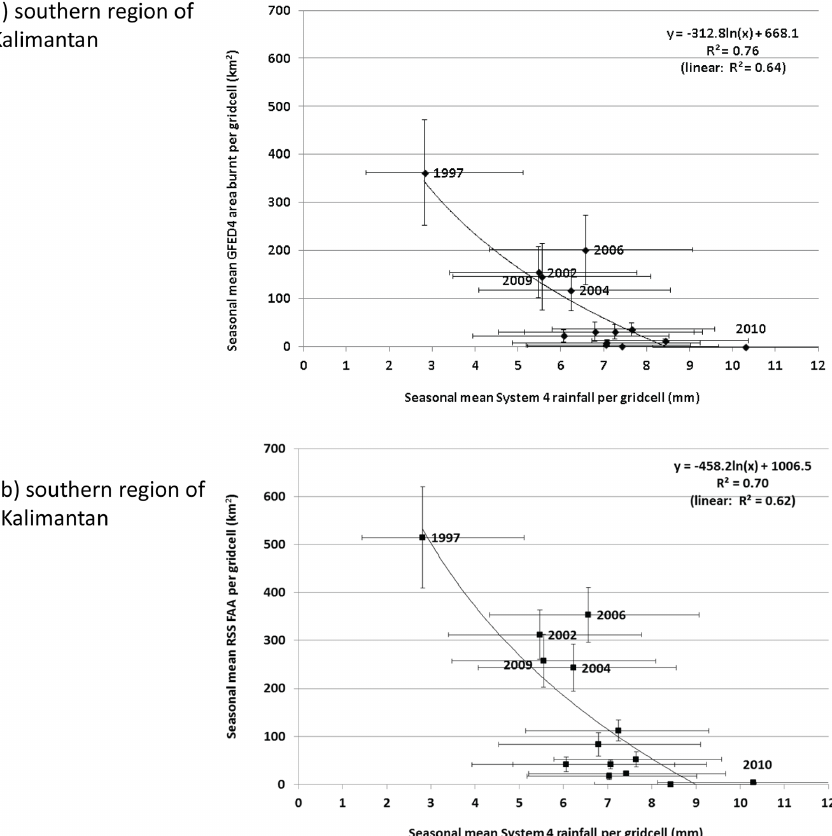
Figure 4. Southern Kalimantan: (a) seasonal mean GFED4 burnt area per grid cell as a function of seasonal mean System 4 rainfall per grid cell; (b) seasonal mean RSS fire-affected area (FAA) per grid cell as a function of seasonal mean System 4 mean rainfall per grid cell. Number of System 4 grid cells in southern Kalimantan is 23. The edges of the burnt and fire-affected area whiskers refer to the 5th and 95th percentiles respectively ( ± 1.96 × SE mean ). The upper edge of the System 4 whiskers is mean upper tercile –mean middle tercile , and the lower edge of the System 4 whiskers is mean middle tercile –mean lower tercile (refer to data preparation in